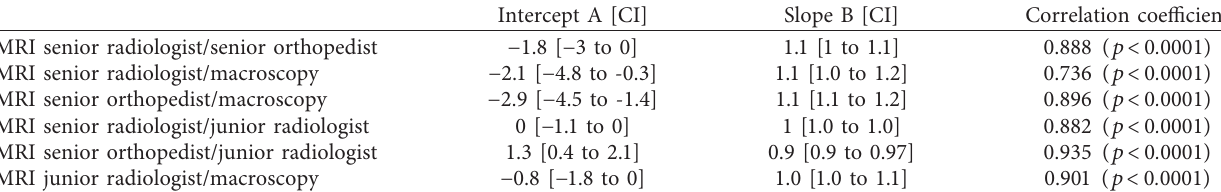
Table 3: Differences between the methods according to Passing–Bablok regression.